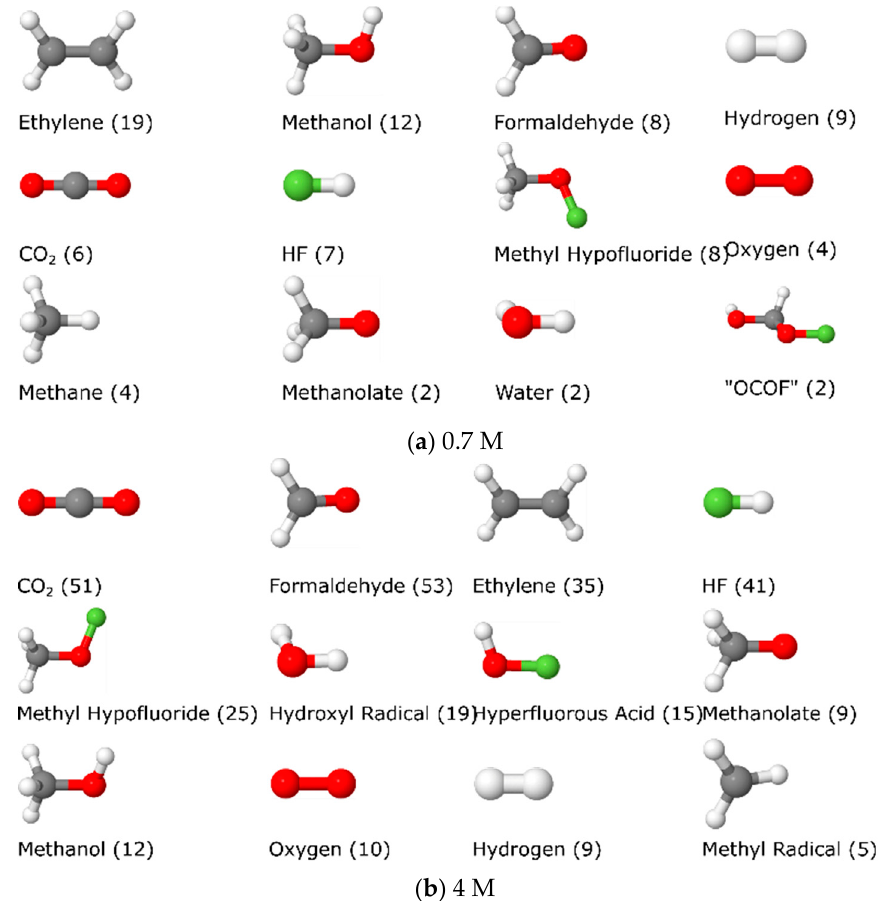
Figure 10. The 12 most abundant molecules during the reactive dynamics of both systems: 0.7 M LiTFSI ( a ) and 4 M LiTFSI ( b ). Noted in brackets are their respective numbers in the last trajectory frame.